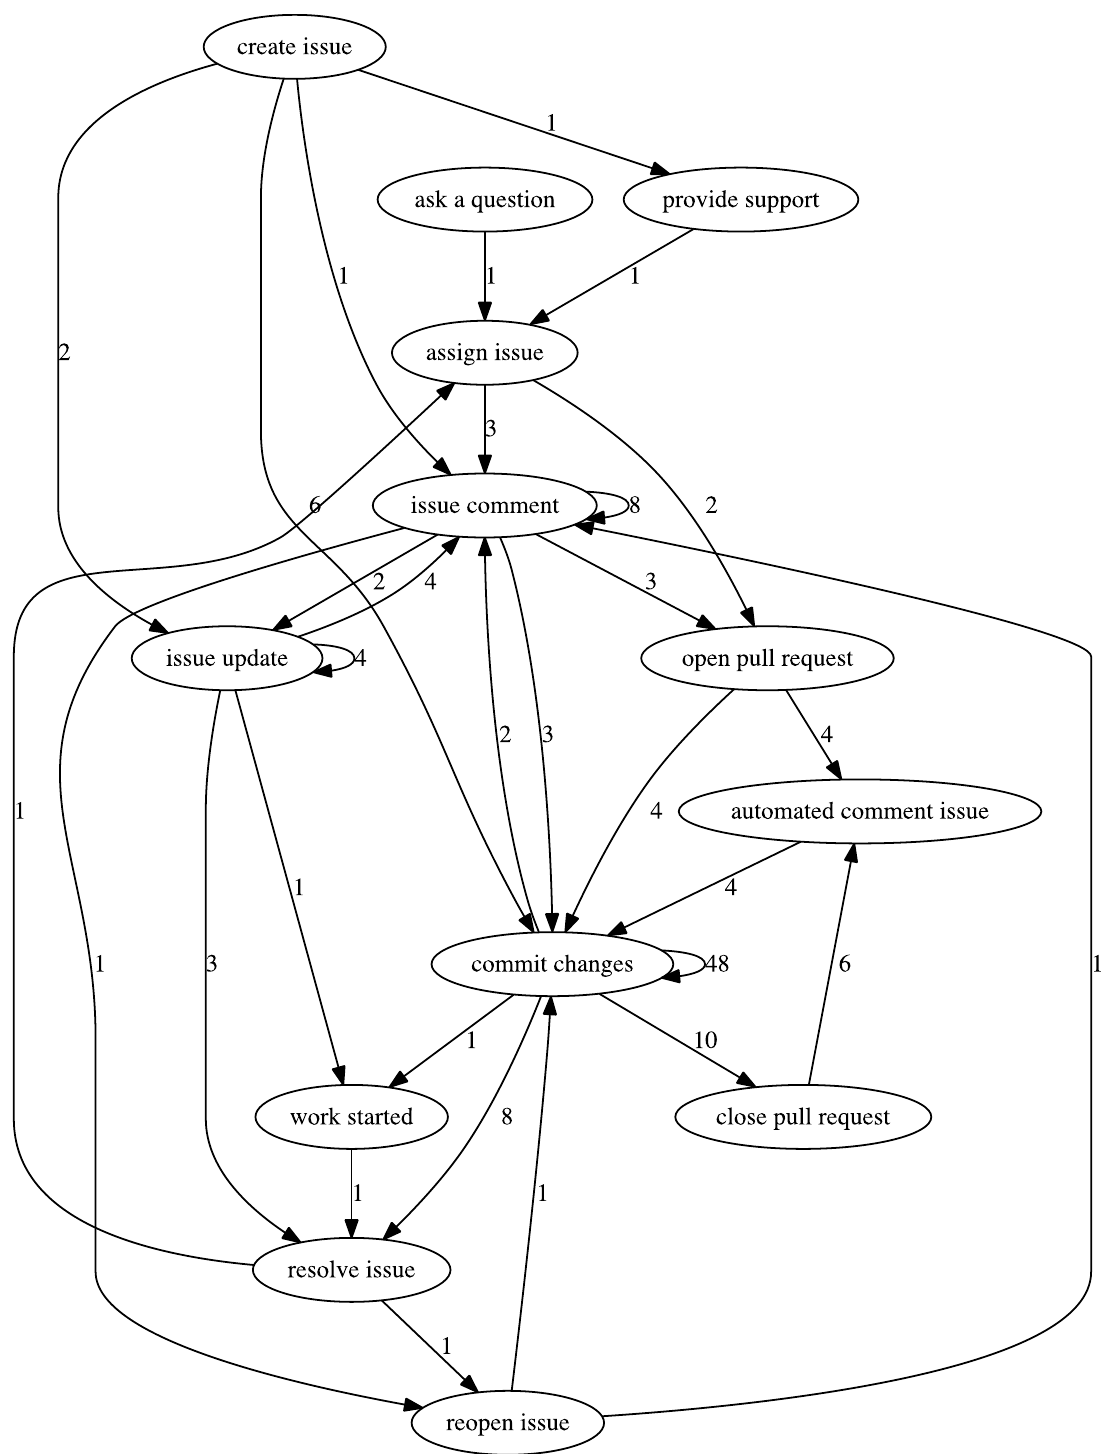
Fig 3. Workflow digraph containing the actions relating to a “bugfix”. Numbers between each directed edge (including self referential connections) indicate the number of instances of this connection.